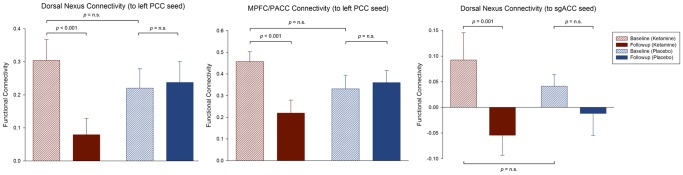
Functional connectivity across the whole experiment.The bar diagrams represent the functional connectivity (Fisher z-transformed correlation values after global mean regression) for the following experimental conditions: baseline and follow-up (ketamine; red); baseline and follow-up (placebo; blue). From left to right: Dorsal nexus (DN) connectivity to the left posterior cingulate cortex (PCC); medioprefrontal cortex (MPFC) and pregenual anterior cingulate cortex (PACC) connectivity to the left PCC; subgenual anterior cingulate cortex (sgACC) connectivity to the DN (n = 17, paired t-tests; error bars = s.e.m.).